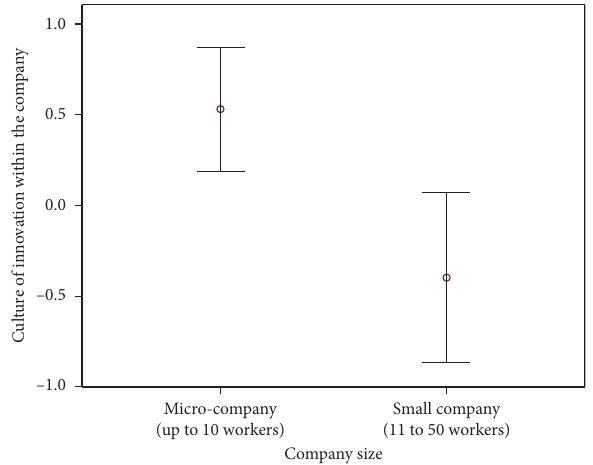
Figure 4: ANOVA culture of innovation within the company/ company size, 95% least significance difference